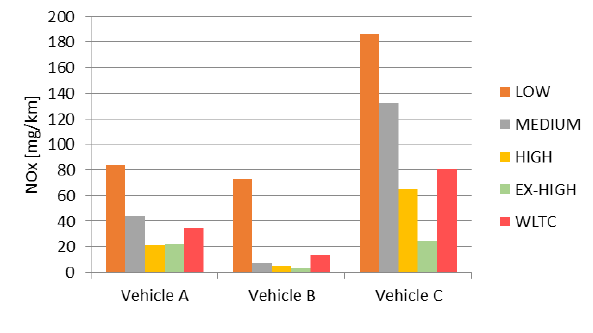
Fig. 10. Nitrogen oxides emissions in WLTC test and its particular stages